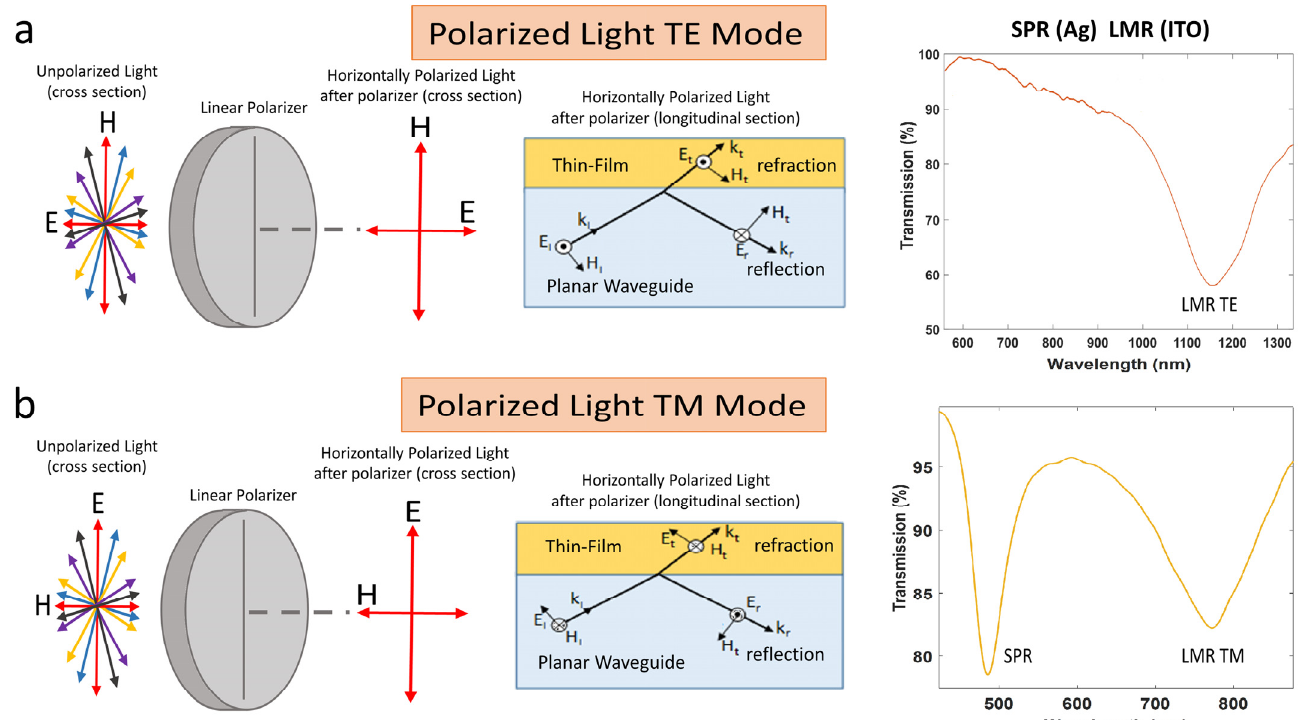
Figure 1. Schematic view of SPR and LMR excitation for: ( a ) Horizontally polarized light (only LMR TE is excited); ( b ) Vertically polarized light (SPR and LMR TM are excited).